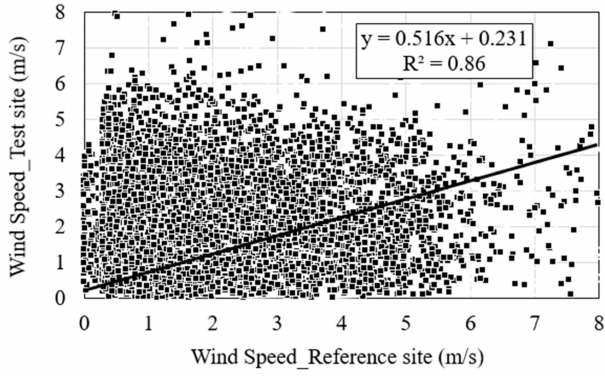
Figure 4. Measured wind speed comparison at both sites for training year 2016.